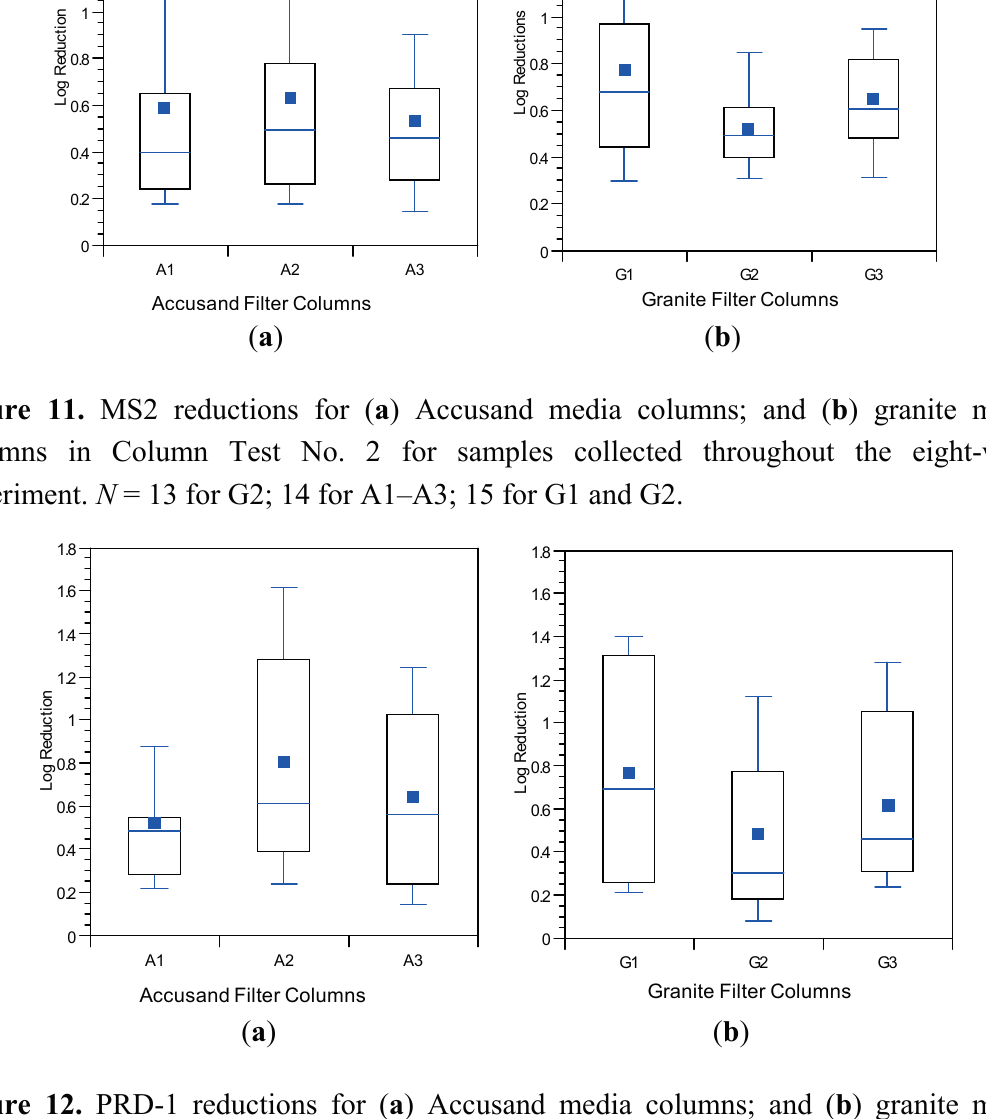
Figure 12. PRD-1 reductions for ( a ) Accusand media columns; and ( b ) granite media columns in Column Test No. 2 for samples collected throughout the eight-week experiment. N = 13 for G2; 14 for A1–A3; 15 for G1 and